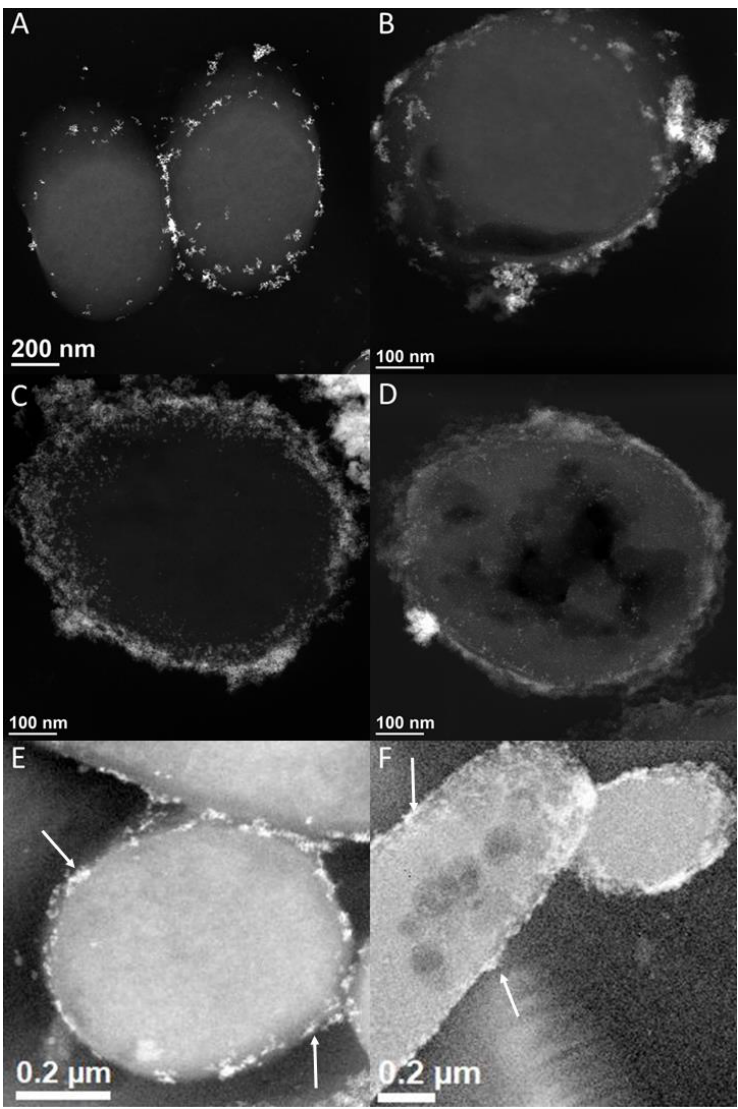
Figure 4. Scanning transmission electron microscopy high-angle annular dark field (STEM-HAADF) dark field images and energy filtered transmission electron microscope (EFTEM) Pd elemental maps comparing Pd(0) nanoparticle formation in different C. acetobutylicum strains. STEM-HAADF images of Pd(II)-challenged C. acetobutylicum strains with H 2 gas as an electron donor demonstrate localization of Pd(0) nanoparticle formation on the surface of ( A ) ΔhypF / hypD ; ( B ) M5; ( C ) WT; and, ( D ) dead WT cells (heat killed); EFTEM Pd elemental map of ( E ) ΔhypF / hypD and ( F ) WT reveal palladium(0) nanoparticles are located on the extracellular side of the membrane. Palladium(0) maps as bright white particles around the cells. Nanoparticle examples are indicated with white arrows. Scale bars are 200 nm and 100 nm,